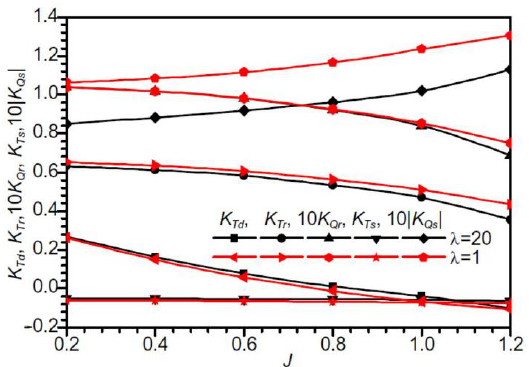
Figure 5. Comparison performance diversities between the full scale and the model scale.